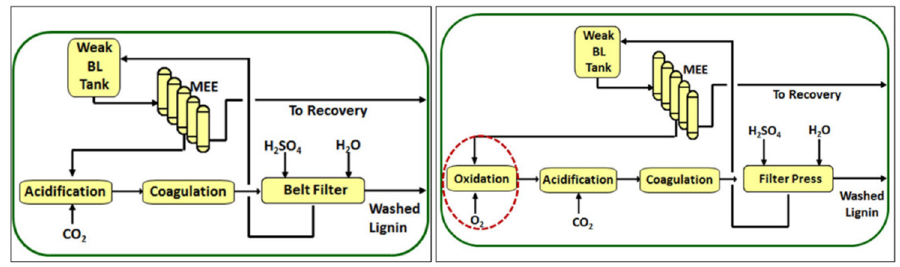
Figure 5. ( Left ) LignoBoost process; ( right ) LignoForce TM